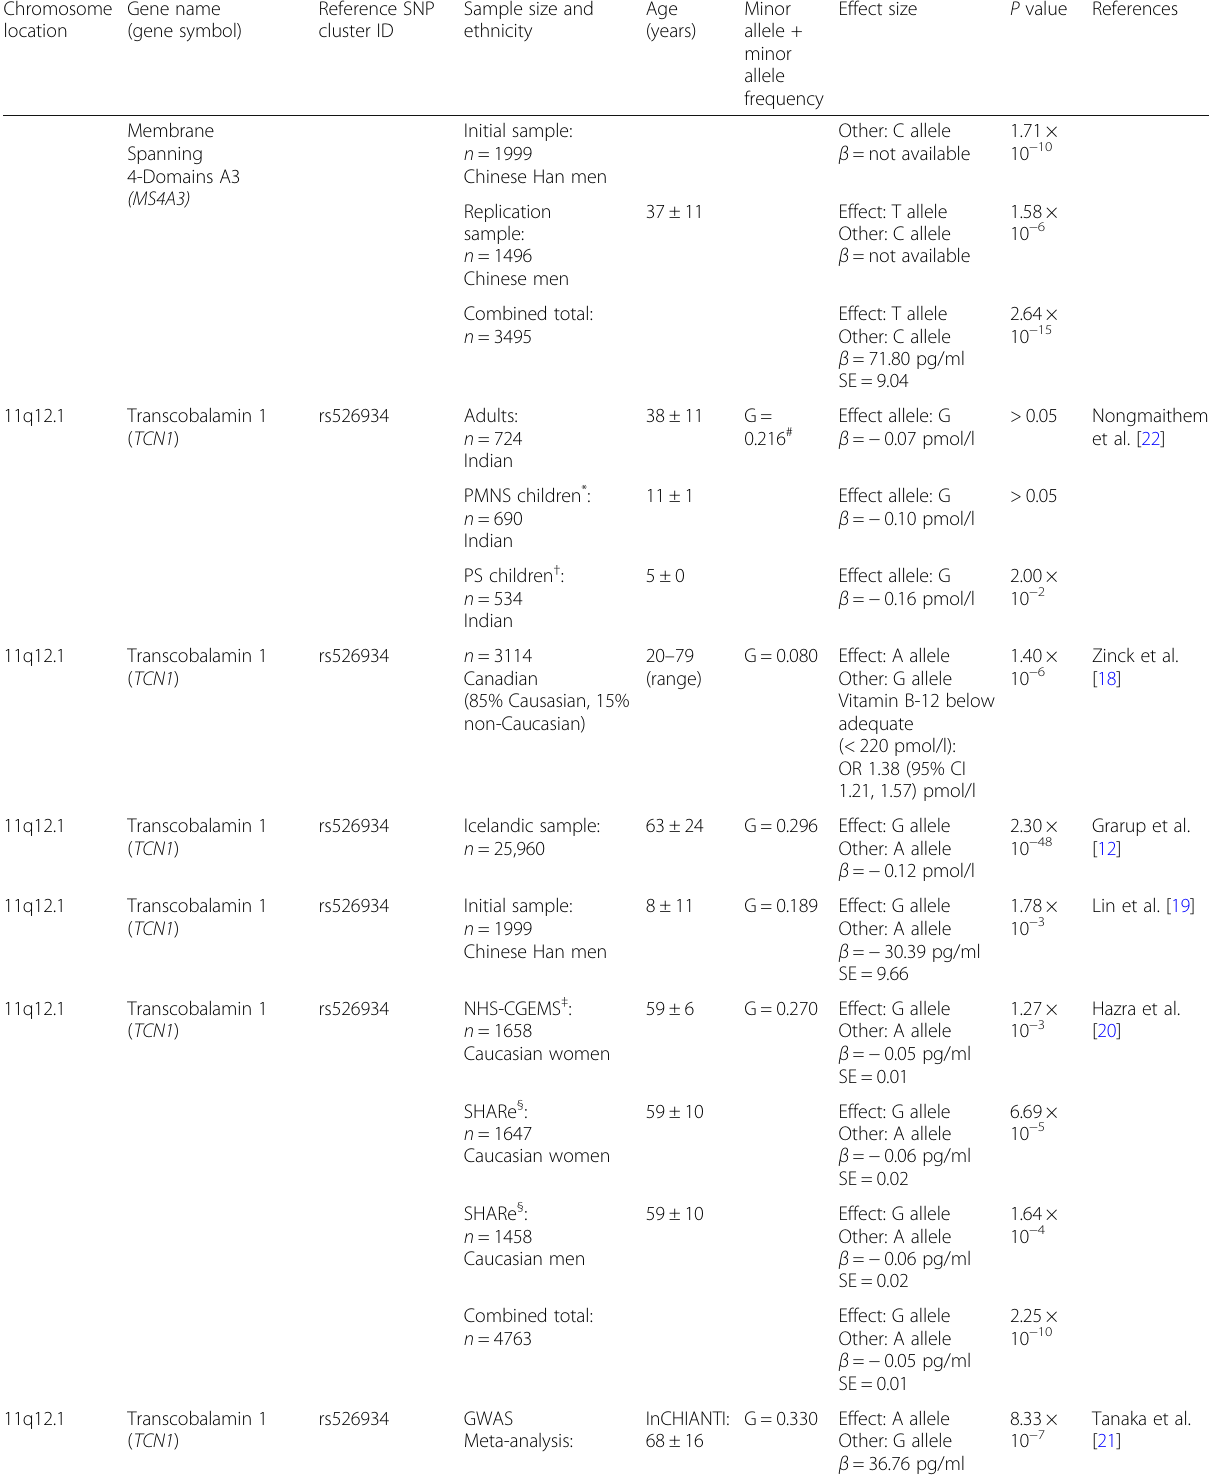
Table 1 Genome-wide association studies showing the association of SNPs with vitamin B12 concentrations. Genome-wide association studies testing the association between SNPs and vitamin B12 concentrations. The chromosome location, gene name, reference SNP cluster ID, sample size and ethnicity, mean age, observed frequency of the minor allele in the population, effect size and P value are shown in the table. The order of SNPs reflects the order of the chromosome location